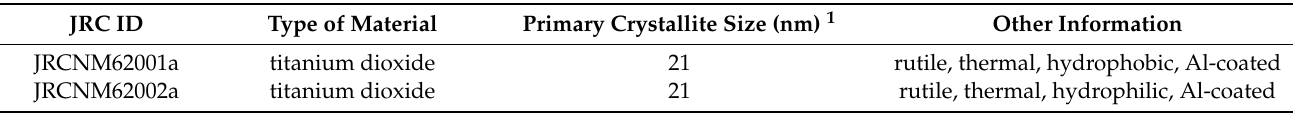
Table 2. Main physicochemical parameters of the titanium dioxide material according to the Joint Research Centre (JRC) repository. JRC ID Type of Material Primary Crystallite Size (nm) 1 Other Information JRCNM62001a titanium dioxide 21 rutile, thermal, hydrophobic, Al-coated JRCNM62002a titanium dioxide 21 rutile, thermal, hydrophilic, Al-coated 1 from